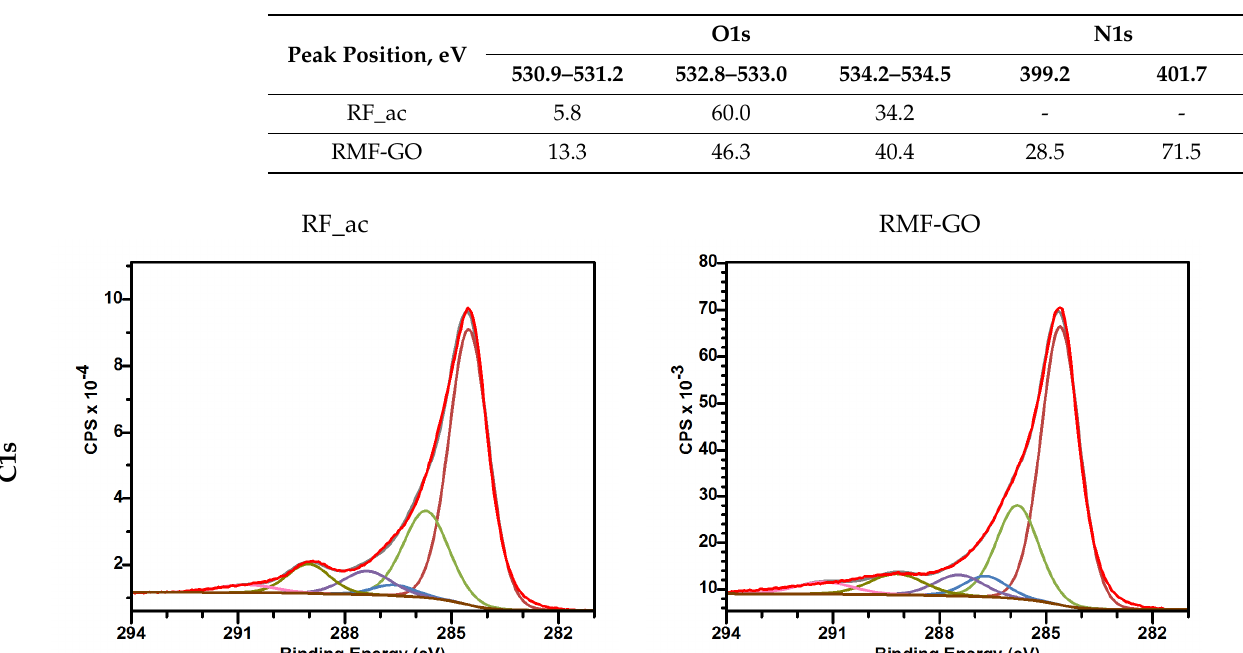
Table 5. Distribution (%) of the oxygen and nitrogen groups.